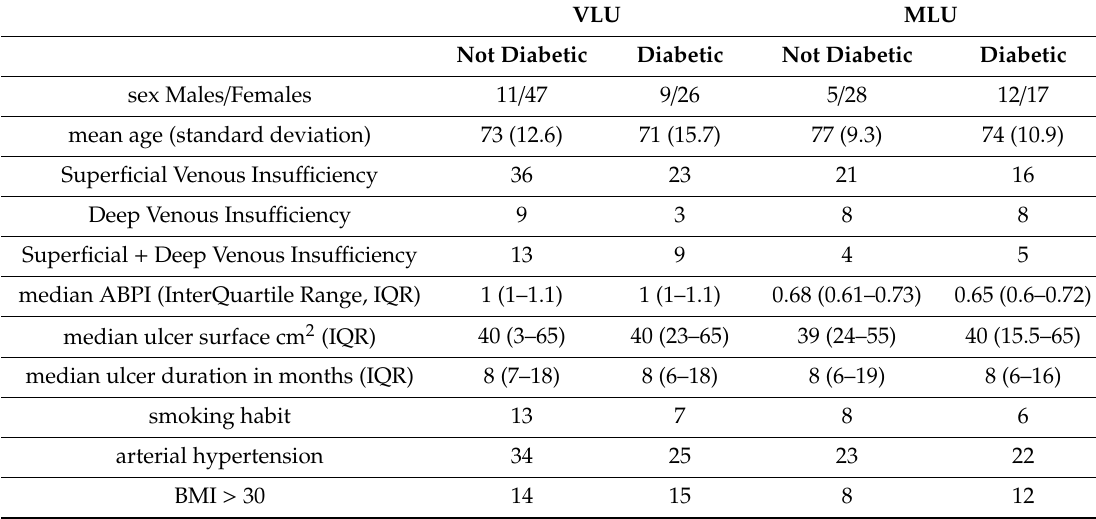
Table 1. Case series demographic features.